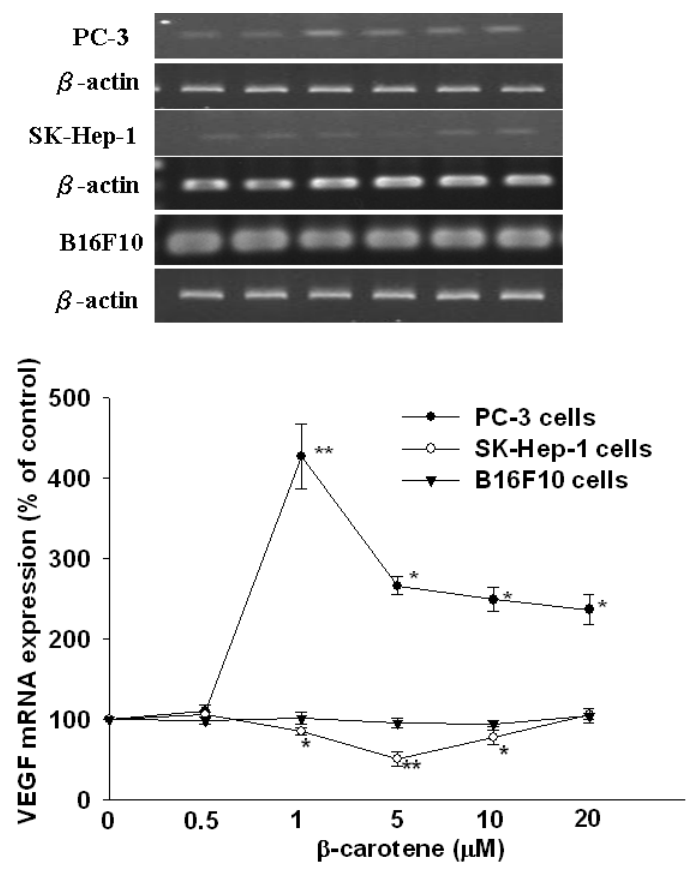
Figure 2. Effect of β -carotene (BC) on mRNA expression of VEGF in SK-Hep-1, PC-2 and B16F10 cells. Cells were incubated with BC (0–20 μ M) for 6 h. Data (means ± SD) are from three or four separate experiments; * P < 0.05; ** P < 0.01 compared to control (0 μ M β -carotene).